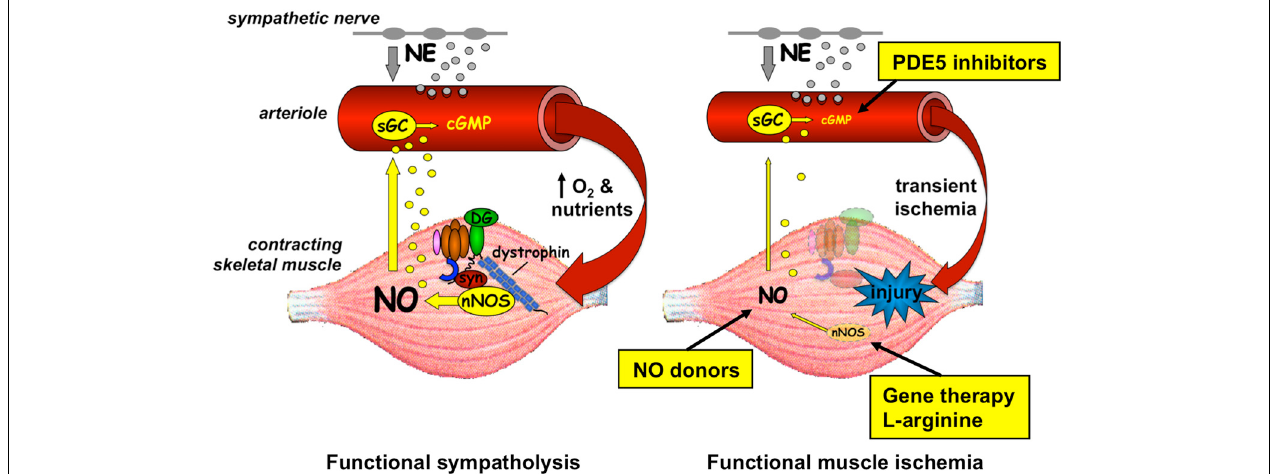
FIGURE 1 | Left panel, in healthy muscle, nNOS μ is localized to the sarcolemma by association with the rod domain of dystrophin and the PDZ domain of α -syntrophin (syn). During muscle contraction, some of the nNOS μ -derived nitric oxide (NO) diffuses to the nearby microvessels where it increases cGMP and attenuates norepinephrine (NE)-mediated vasoconstriction. This NO-mediated functional sympatholysis optimizes blood flow in the working muscles. Right panel , in dystrophic muscle, nNOS μ is reduced in amount and